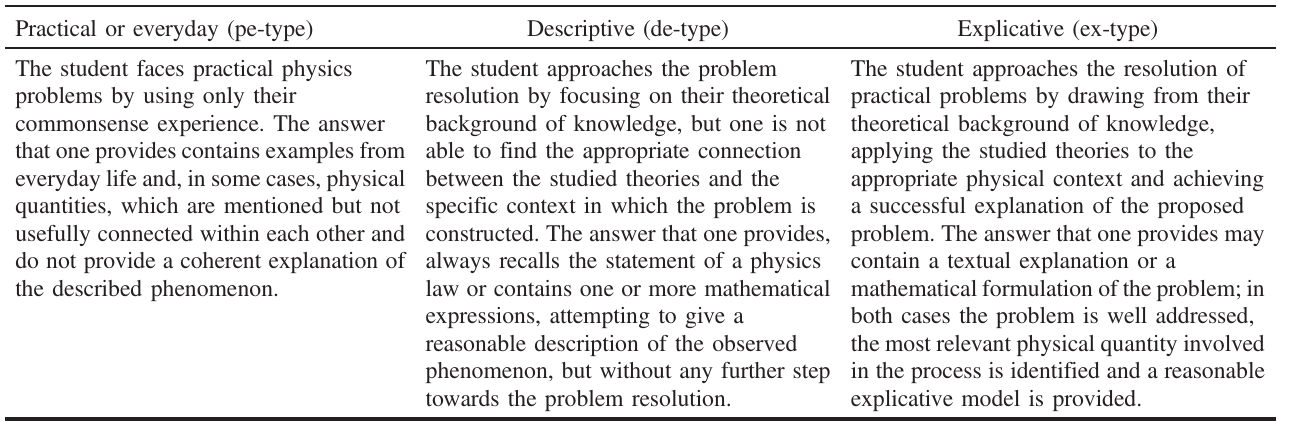
TABLE I. Typology of answering strategies of students facing real-life problematic situations. Practical or everyday